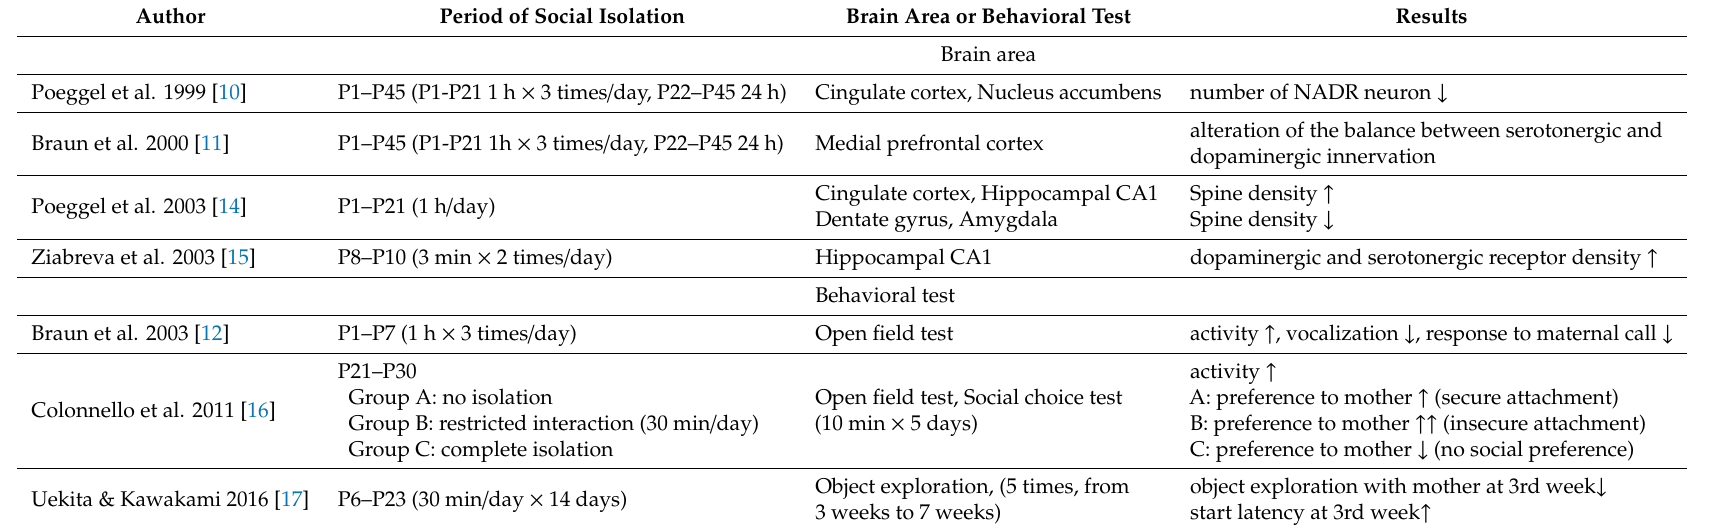
Table 1. Summary of previous studies on the e ff ects of social